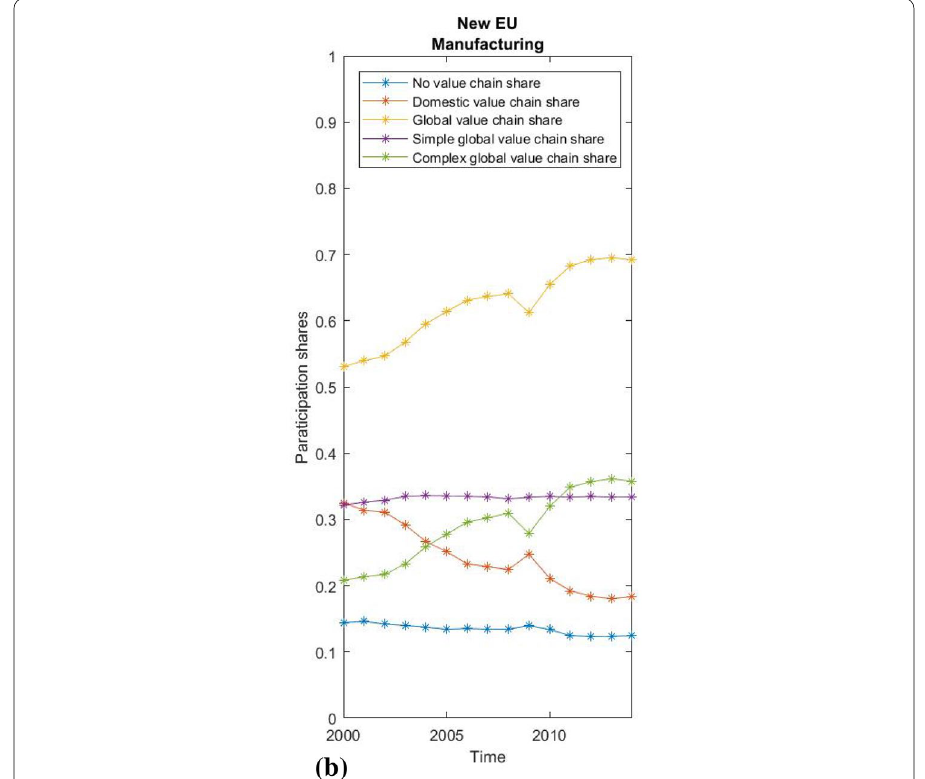
Fig. 6 New EU countries manufacturing. Source: WIOD, 2016; own